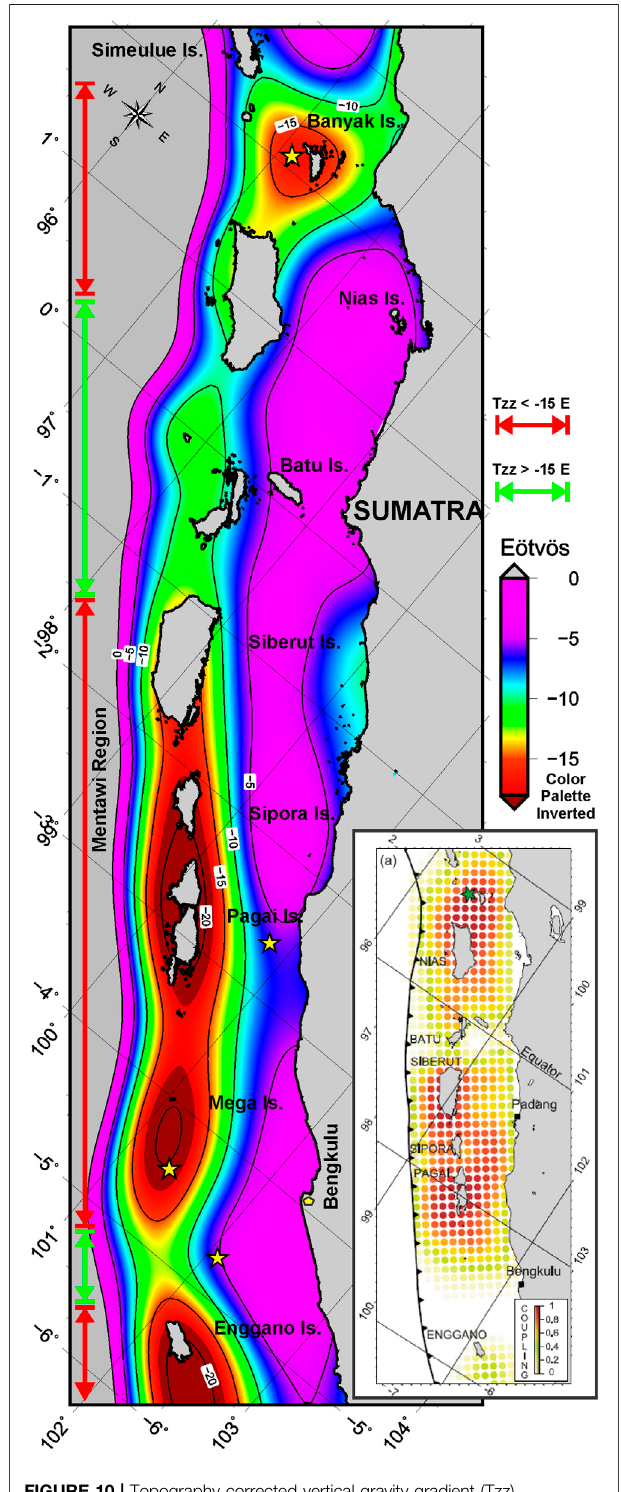
FIGURE 10 | Topography corrected vertical gravity gradient (Tzz) obtained from GOCE model GO_CONS_GCF_2_DIR_R6 up to N (cid:1) 200 (Bruinsma et al., 2014) with color palette inverted. In the right lower corner is FIGURE 10 | term plate convergence. Note the correspondence between plotted the interseismic locking degree from Chlieh et al. (2008): a value highly coupled segments (red) with regions of relative minima Tzz (orange-to- of 1 corresponds to full locking while 0 corresponds to creeping at the long- red) indicated with double red arrows. Regions with intermediate to close to ( Continued ) zero coupling agree with regions of relative higher Tzz (green